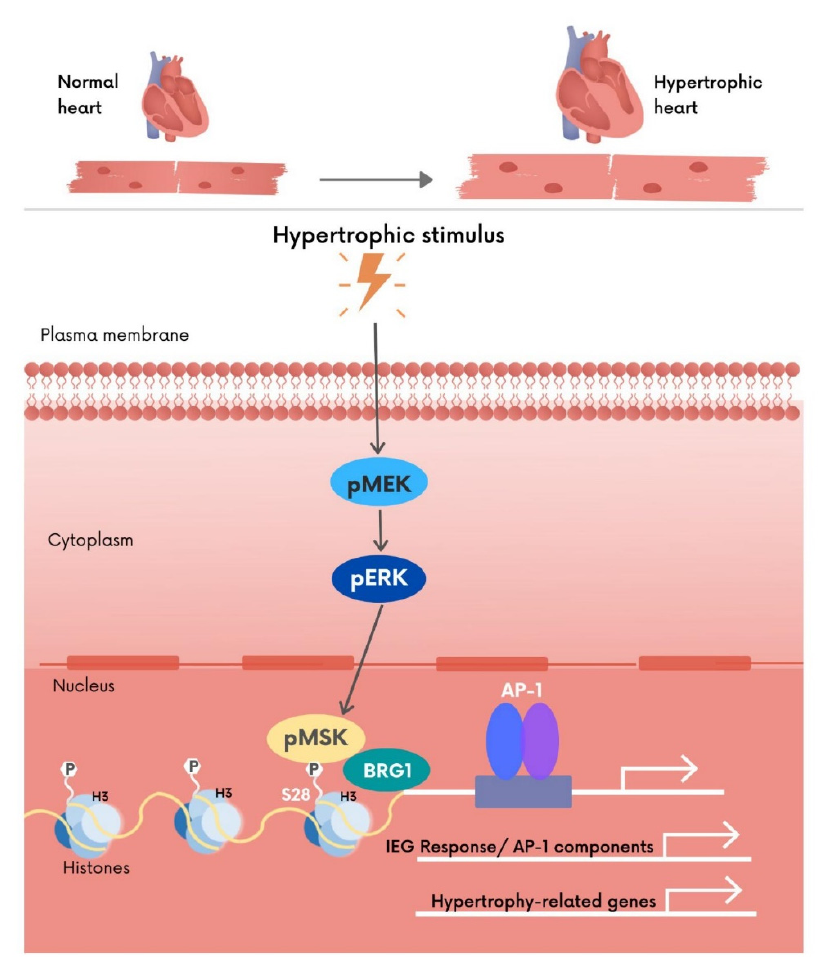
Figure 5. Graphical abstract of main findings of this study indicating pathway by which MSK couples GPCR activation with IEG induction during the cardiac hypertrophic response.